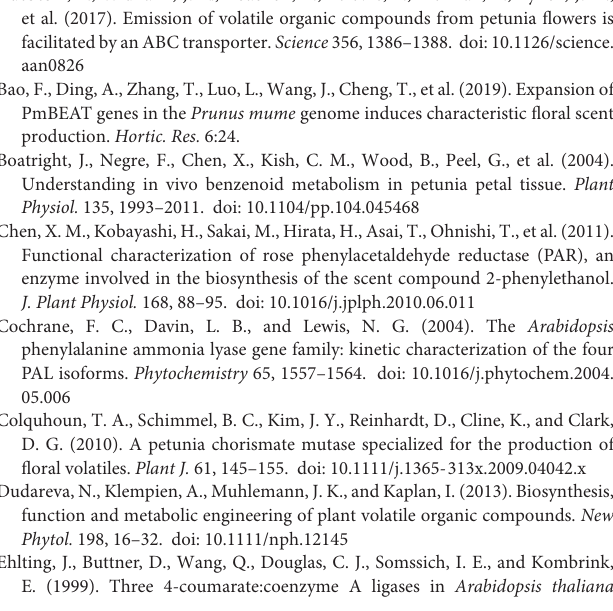
Supplementary Figure 1 | The heat map of correlations between RNA-seq samples. Supplementary Figure 2 | GO significant enrichment analysis of the differentially expressed genes in the five varieties. Supplementary Figure 3 | KEGG pathway enrichment analysis of the differentially expressed genes in the five varieties. Supplementary Figure 4 | Comparison of PmBAR1 coding sequences in the different varieties. Supplementary Figure 5 | Comparison of PmBAR2 coding sequences in the different varieties.